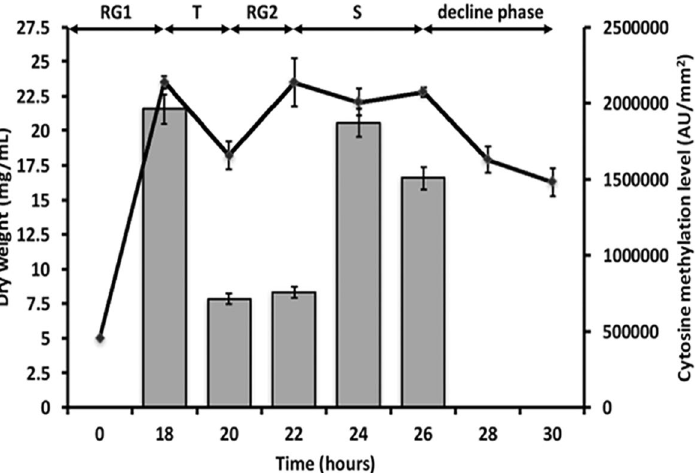
Figure 1. Growth curve of S. coelicolor M145 in the MG medium (continuous curve) and DNA cytosine methylation level (grey bars). The growth was evaluated through evaluation of the dry weight and the methylation level was measured by dot blot